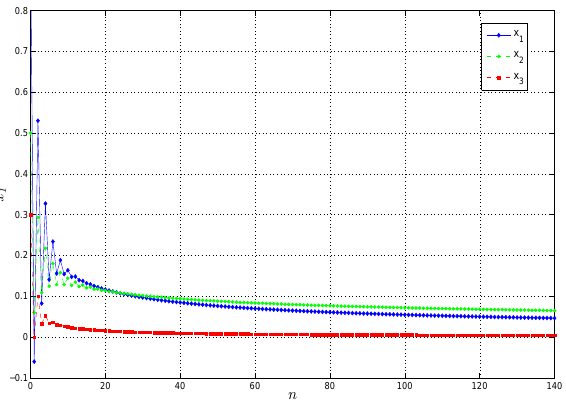
Figure 2. The stability of the zero solution of system